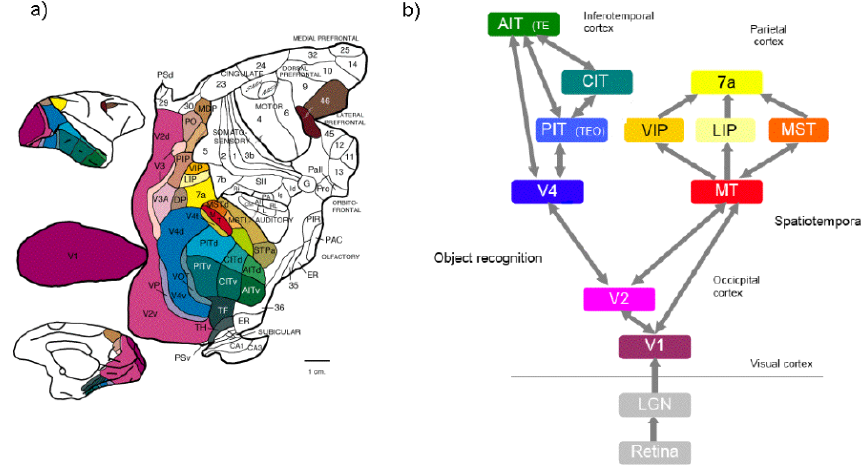
Figure 3. ( a ) Visual cortex of primates, ( b ) simplified version of the visual